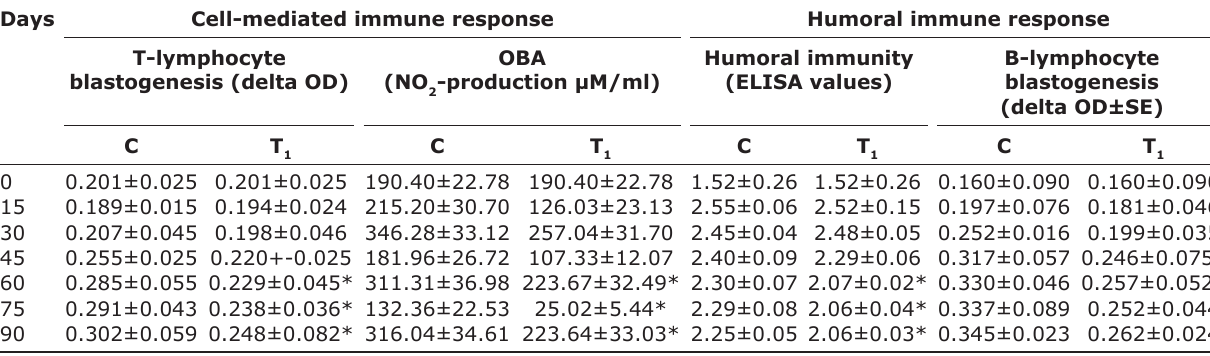
Table-2: Effect of CPF (mean±SE) on cell-mediated and humoral immune response in layers. Days Cell-mediated immune response Humoral immune response T-lymphocyte OBA Humoral immunity blastogenesis (delta OD) (NO -production µM/ml) (ELISA values) 2 (delta